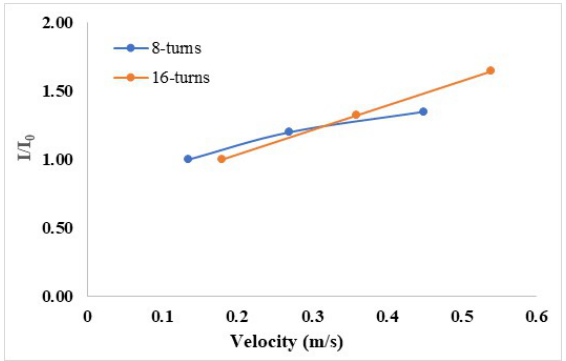
Figure 8. The sensor sensitivity for devices with 8 and 16 turns.